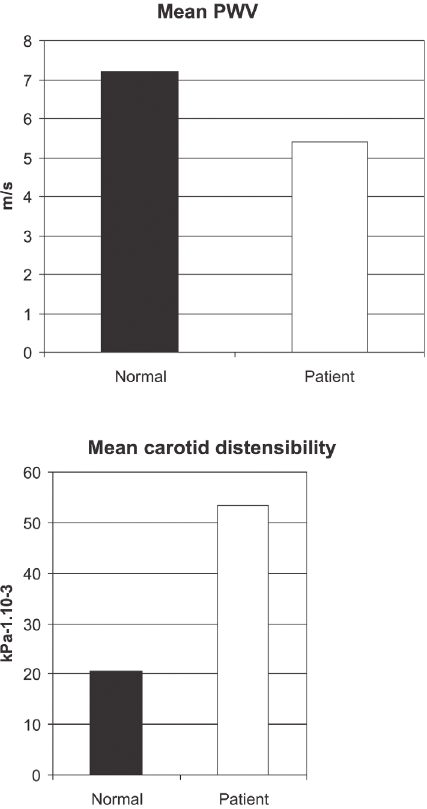
Figure 3 - Vascular data obtained in a group of 10 healthy women aged 14 ± 3 years compared to that of the patient with Goldenhar syndrome: mean pulse wave velocity values (Panel A) and mean carotid distensibility values (Panel B). PWV: Healthy women 7.2 ± 1.2 m/s; patient 5.4 m/s; Carotid distensibility: Healthy women 20.7 ± 5 m/s; patient 53.5